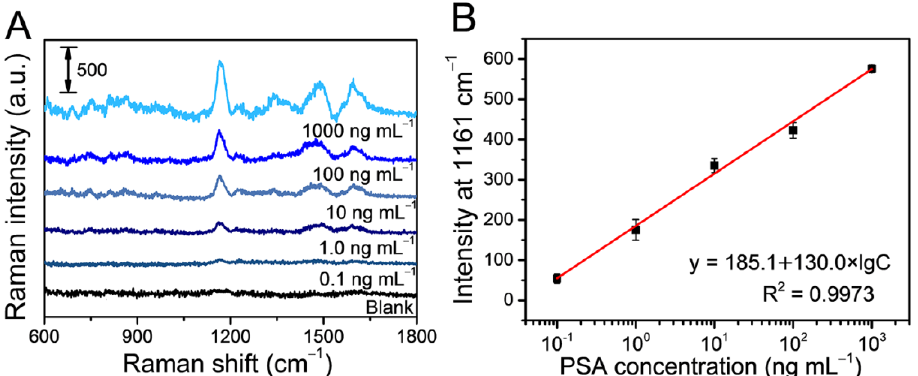
Figure 6. ( A ) SERS spectra of pAuNCs incubated with different concentrations of his-tagged anti- gen on Ni(OH) 2 /TiO 2 films. ( B ) The calibration curve of the intensity of SERS signals at 1161 cm −1 versus the concentration of his-tagged antigen.